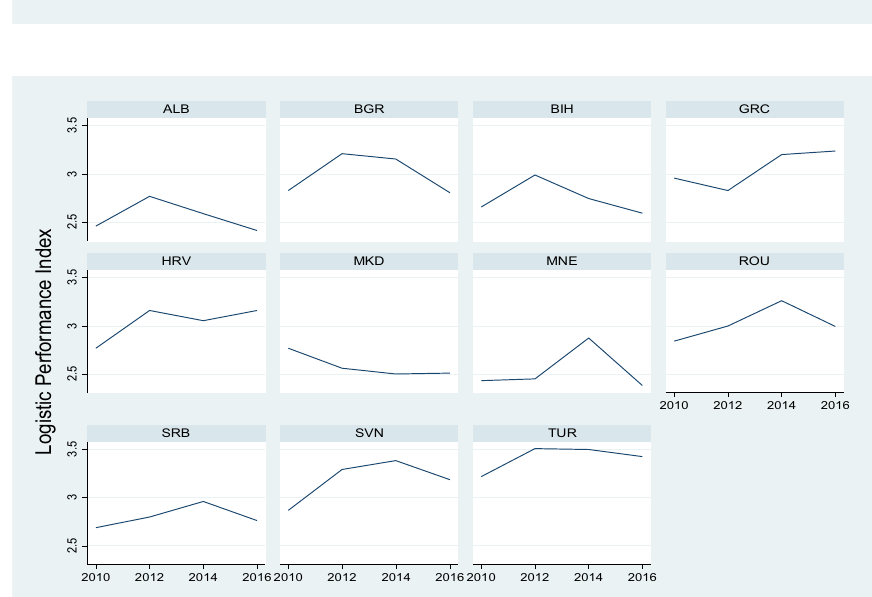
Figure 5. LPI scores of the selected Balkan countries (2010 –